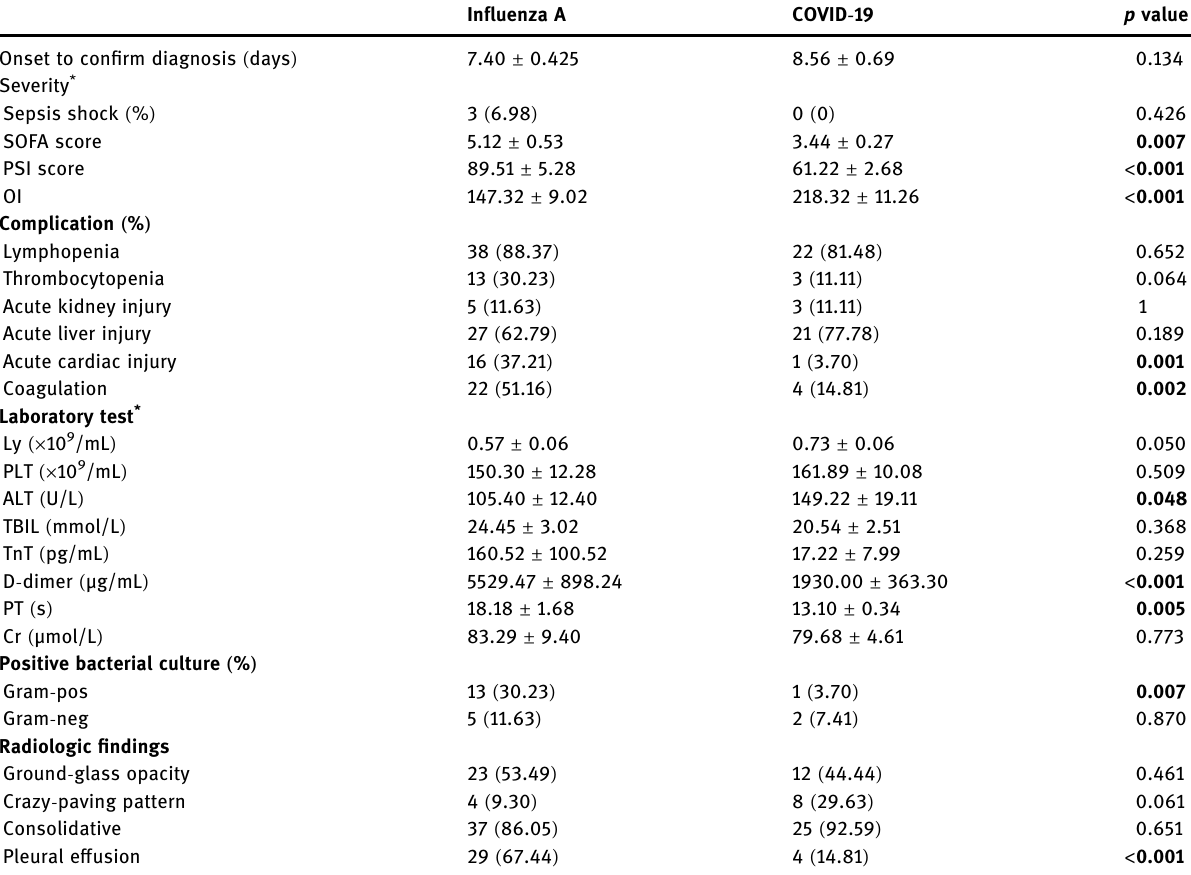
Table 2: Over disease ’ s course between of severe in fl uenza A and COVID - 19 patients